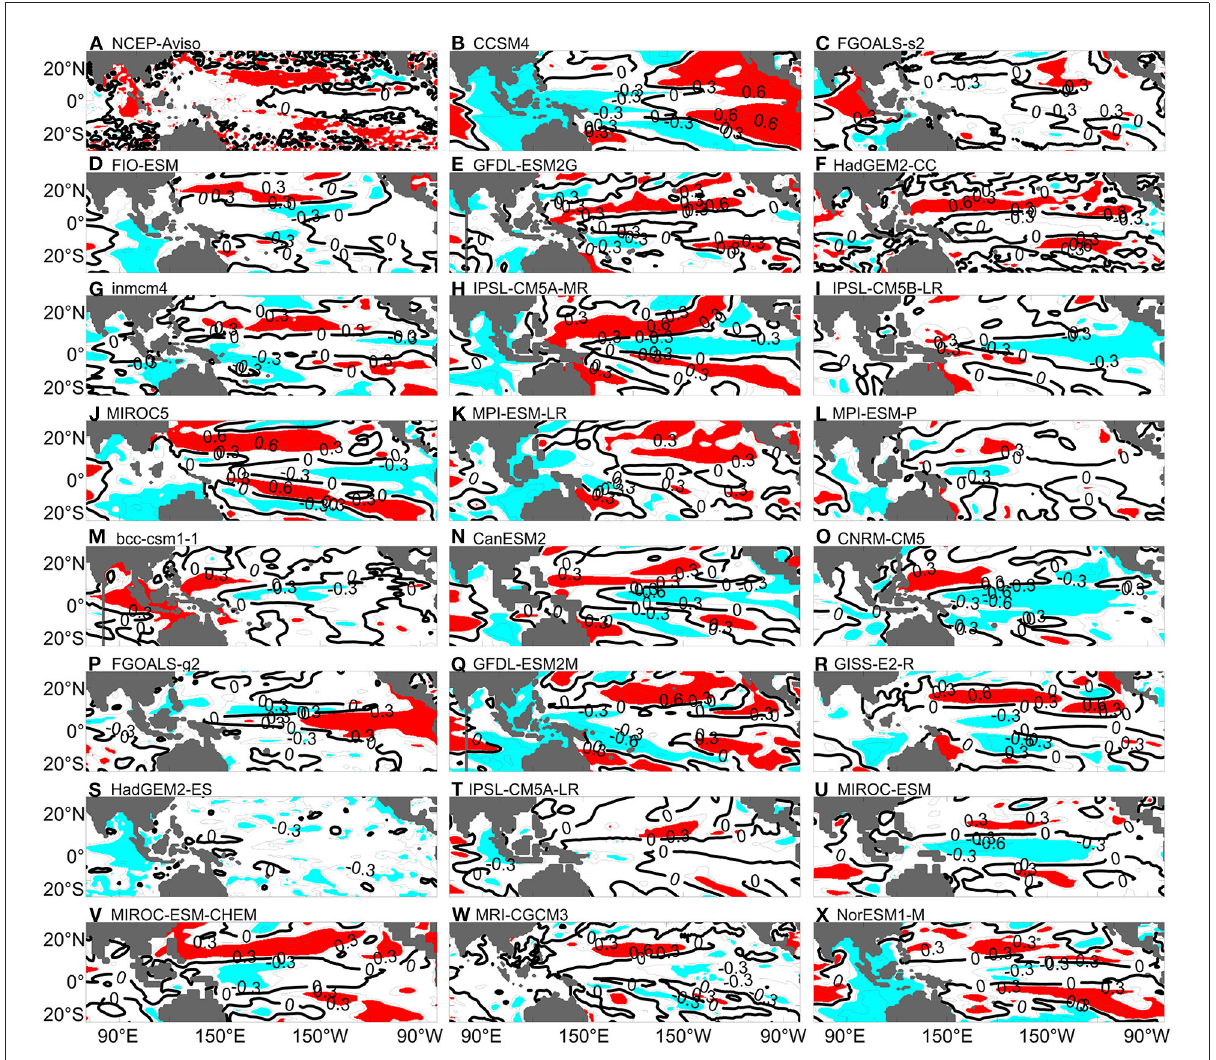
FIGURE10 Composite lag correlations between the WEP SZWA in the fall of Year 0 and tropical Indo-Pacific SSHA in the fall of Year + 1 in NCEP/Aviso and CMIP5 historical simulations during positive phases. The red and blue shading indicate the 95% significance level of positive and negative correlations, respectively. Index (A–X) refers to different CMIP5 model as listed in Supplementary Table